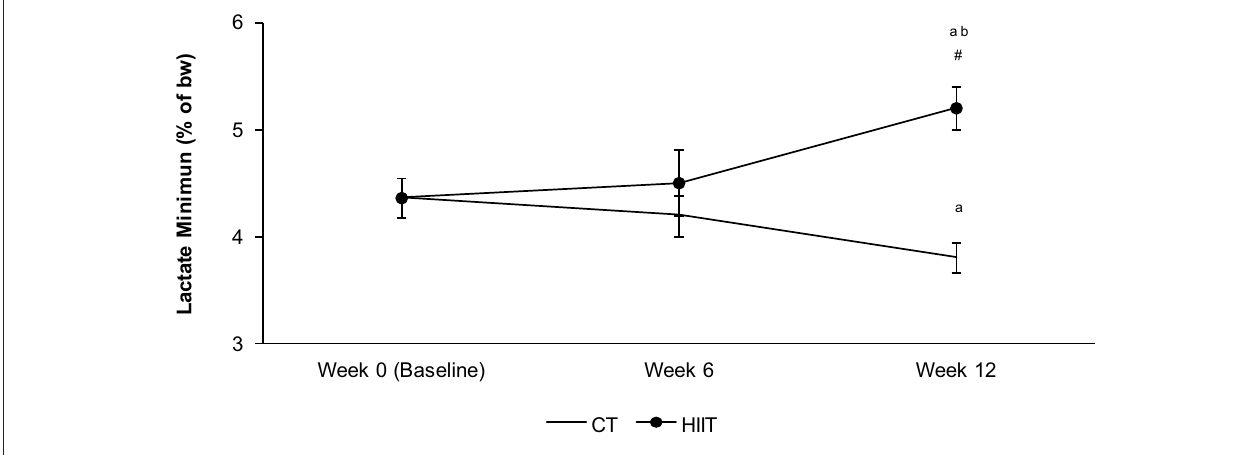
FIGURE 1 | Aerobic capacity measured by Lactate minimum test in each period of training (0 week—baseline, 6 weeks—HIIT short term and 12 weeks—HIIT long term). The intensity of lactate minimum test was determined by % of the body weight (bw). a Significantly different ( P < 0.05) in relation to baseline. b Significantly different (P < 0.05) in relation to HIIT short term (6 week). # Significantly different ( P < 0.05) in relation to CT group in respective period.